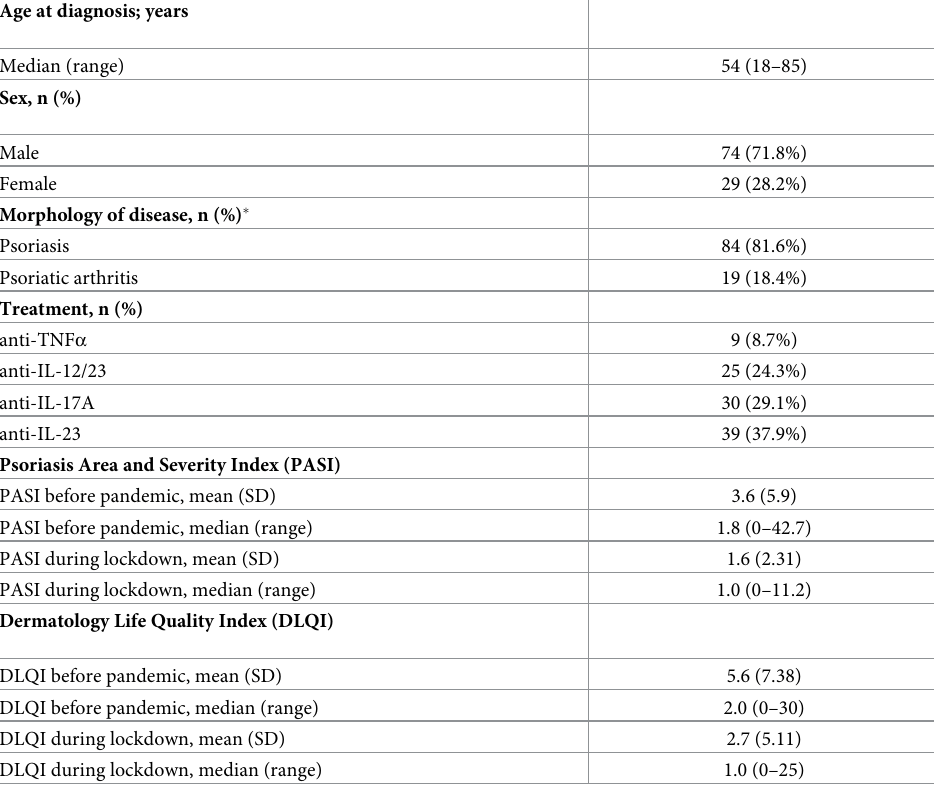
Table 1. Demographic and clinical